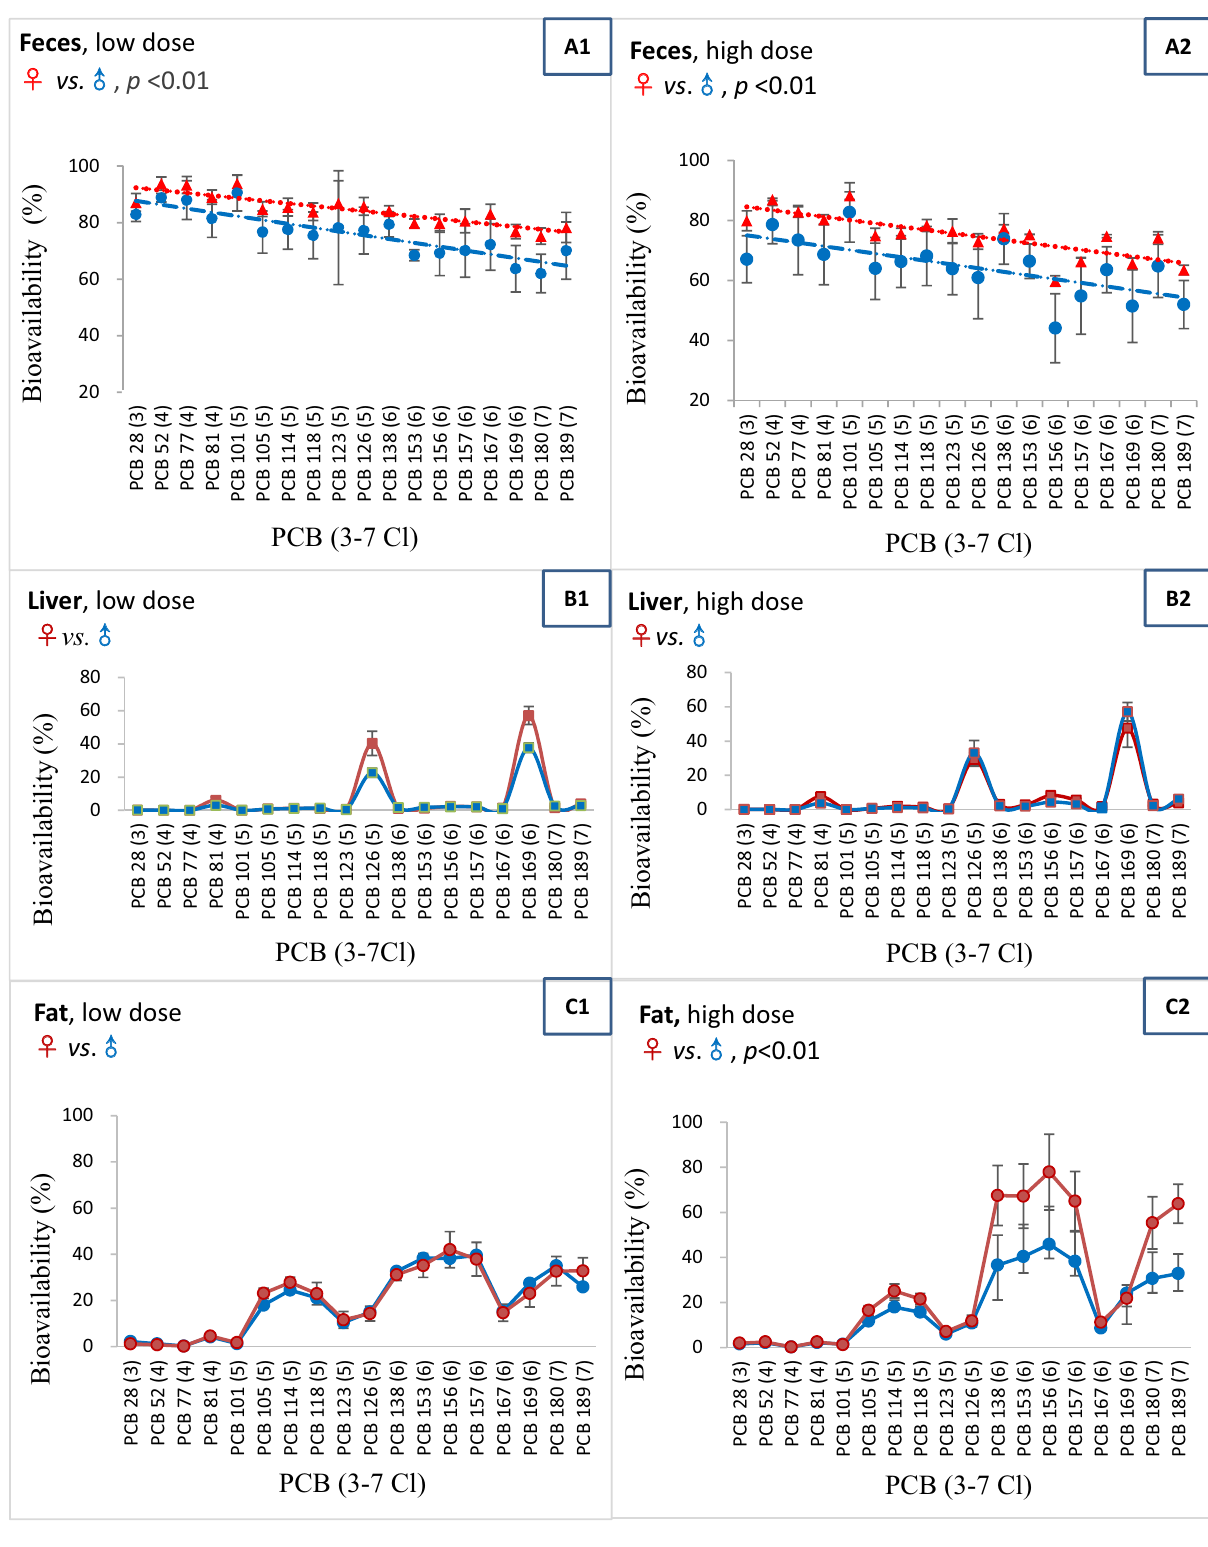
Figure 2. PCB congener bioavailability measured by different endpoints. Female ( ♀ ) data were presented in red and male ( ♂ ) data in blue. R: Pearson’s correlation coefficient; For PCBs: Low dose: 1 ng /100 g b.w./d; High dose: 5 ng/100 g